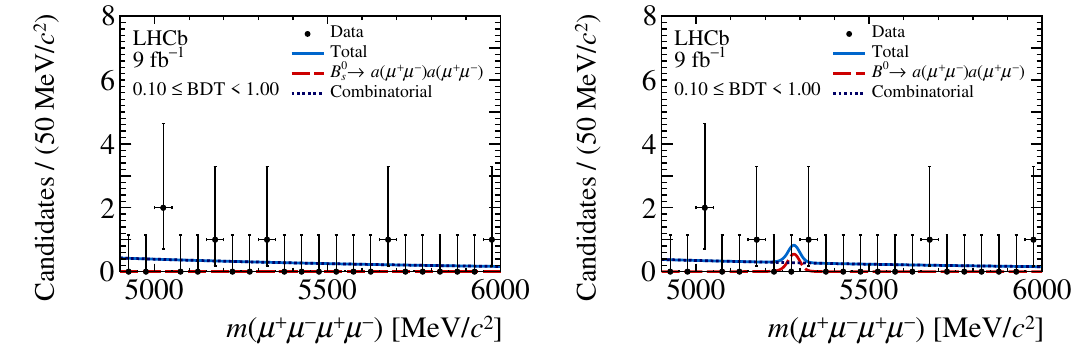
Figure 4 . Distribution of the µ + µ − µ + µ − invariant mass of candidates passing the B 0 → a ( µ + µ − ) a ( µ + µ − ) selection, with the fit models used to determine the branching fractions ( s ) of (left) B 0 → a ( µ + µ − ) a ( µ + µ − ) and (right) B 0 → a ( µ + µ − ) a ( µ + µ − ) decays overlaid. s